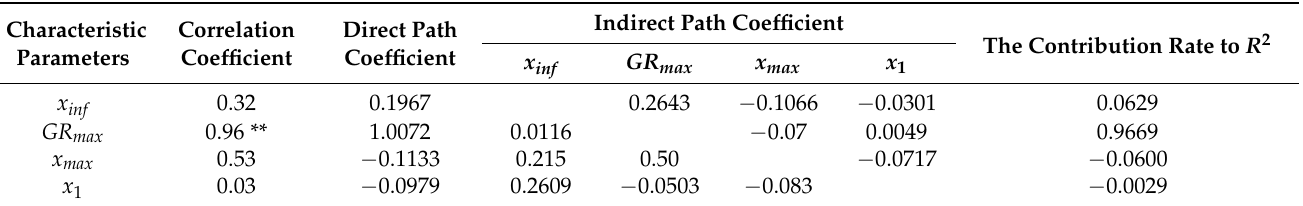
Table 8. Path analysis of the final dry matter accumulation ( a ) and the characteristics of the dynamic process. ** indicates significant correlation at p < 0.01